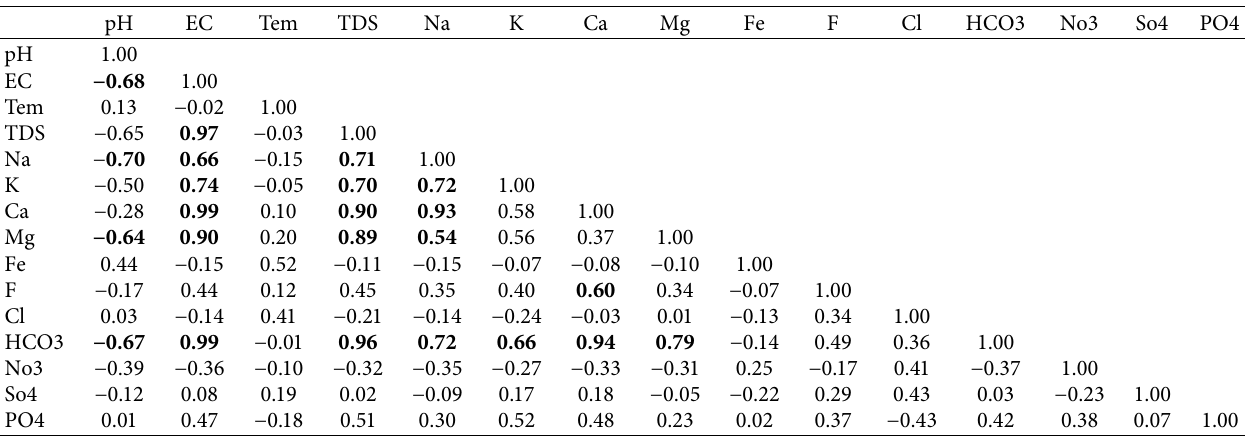
Figure 19: Graphs of diferent interionic ratios in groundwater of the study area. Table 2: Correlation matrix of physicochemical